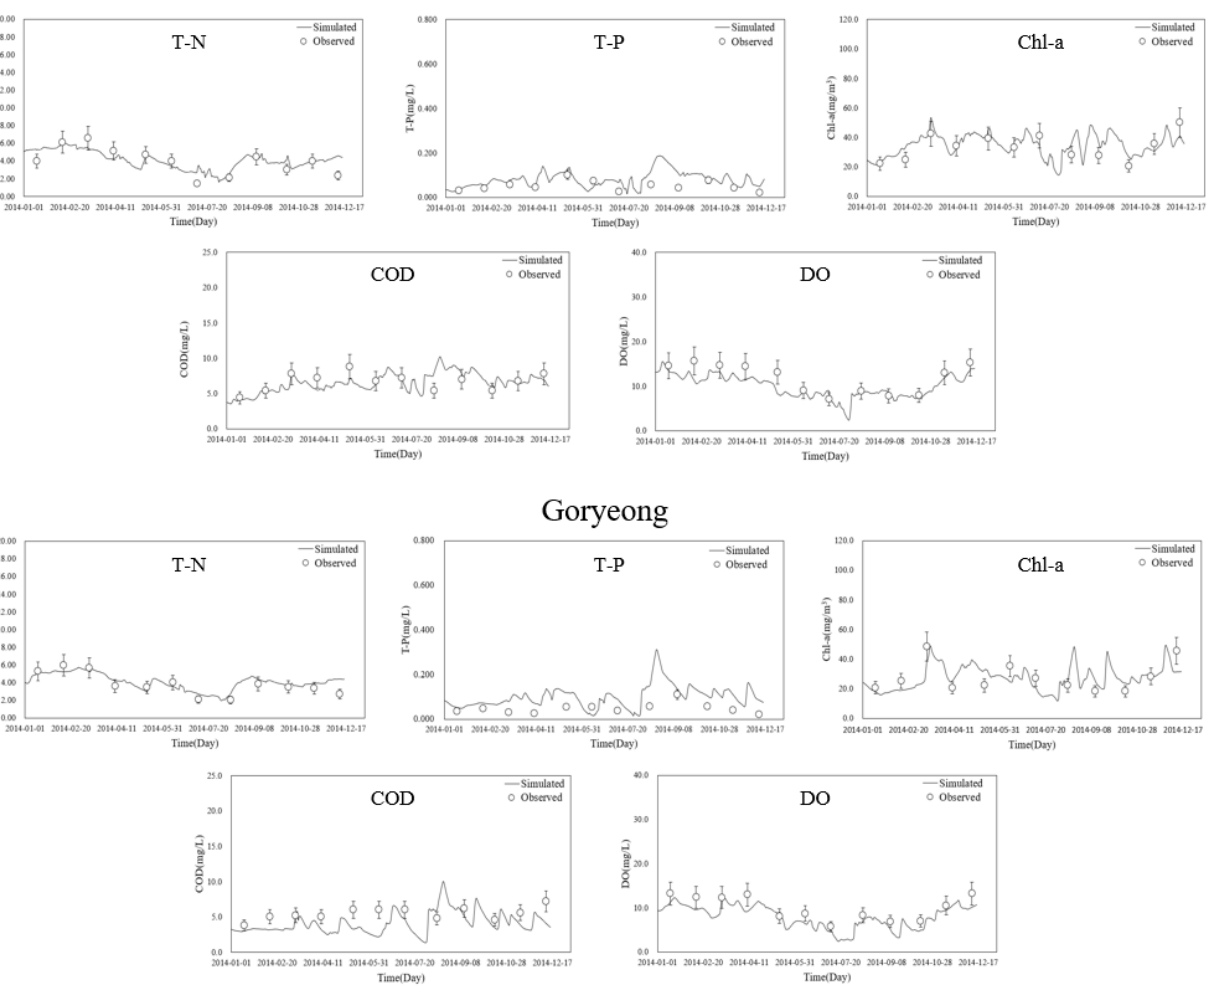
Figure 5. Water Quality Simulation Calibration (From January 2014 to December 2014) .